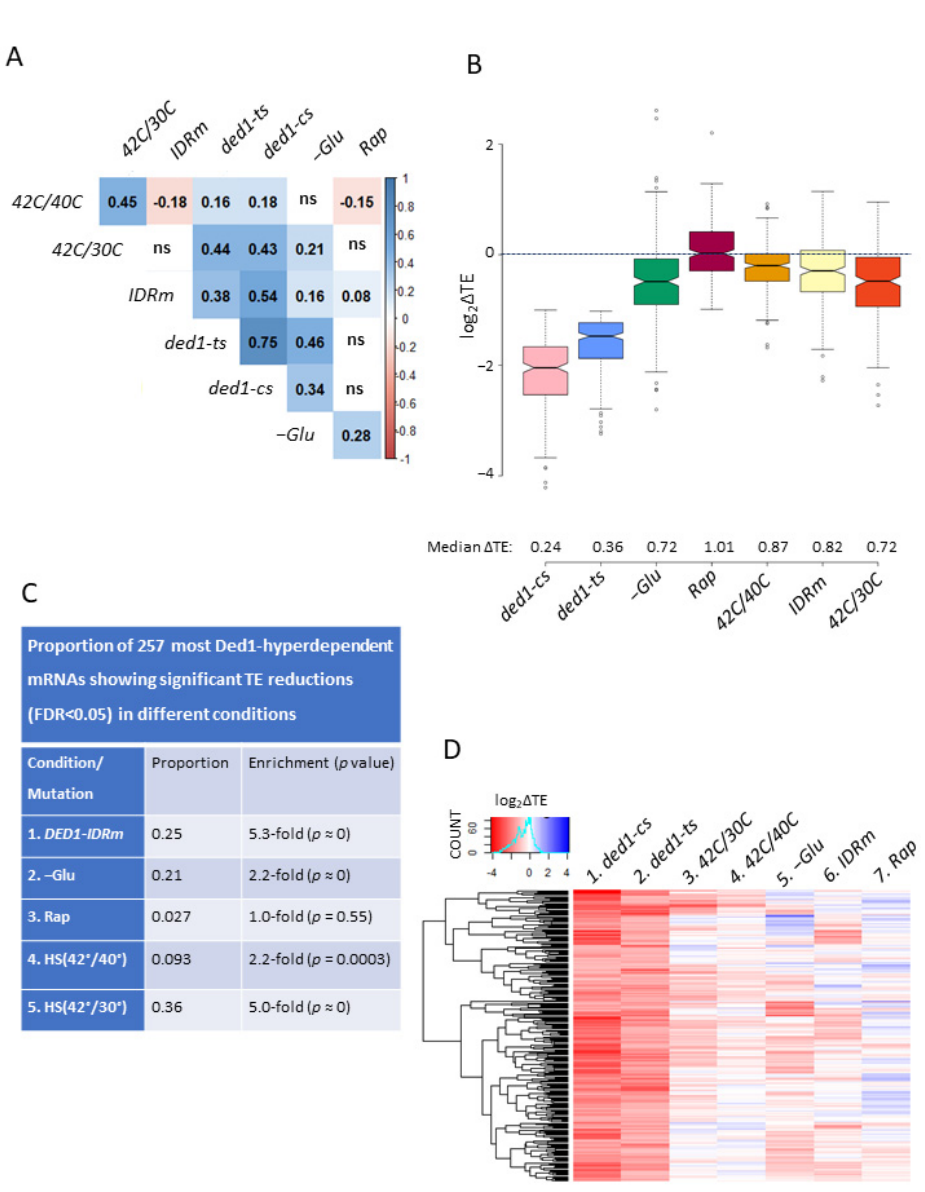
Figure 4. The TE changes produced by the DED1-IDRm mutation at 42 ◦ C, glucose starvation, and heat-shock at 42 ◦ C versus 30 ◦ C most closely resemble those conferred by the ded1-ts and ded1-cs mutations. ( A ) Spearman correlation coefficients of TE changes for 745 Ded1-dependent mRNAs exhibiting ≥ 1.5-fold increases or decreases in TE in ded1-ts versus WT cells at FDR < 0.05 in response to the indicated mutations or stresses. ns, correlations not statistically significant. ( B ) Notched box plots showing log 2 fold-changes in TE in response to the indicated mutations or stresses for the group of 257 mRNAs showing >2-fold reductions in TE in both ded1-ts and ded1-cs mutants (2X_TE_down_ ded1-cs _ ∩ _ ded1-ts ). ( C ) Overlap analyses of the 257 Ded1-hyperdependent mRNAs described in ( B ) and the groups of mRNAs showing significant TE reductions in response to the indicated ded1 mutations or stresses. ( D ) Hierarchical cluster analysis results of TE change values for the 257 mRNAs in ( B ) in response to the indicated ded1 mutations or stresses; this analysis was conducted with the R heatmap.2 function from the R ‘gplots’ library using the default hclust hierarchical clustering